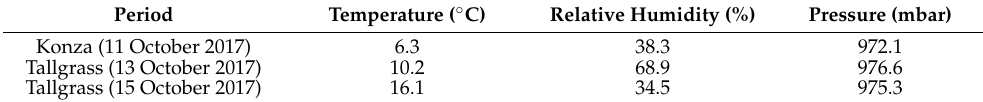
Table 2. Meteorological parameters for Fall 2017 study days (averaged over daily measurement pe- riod).